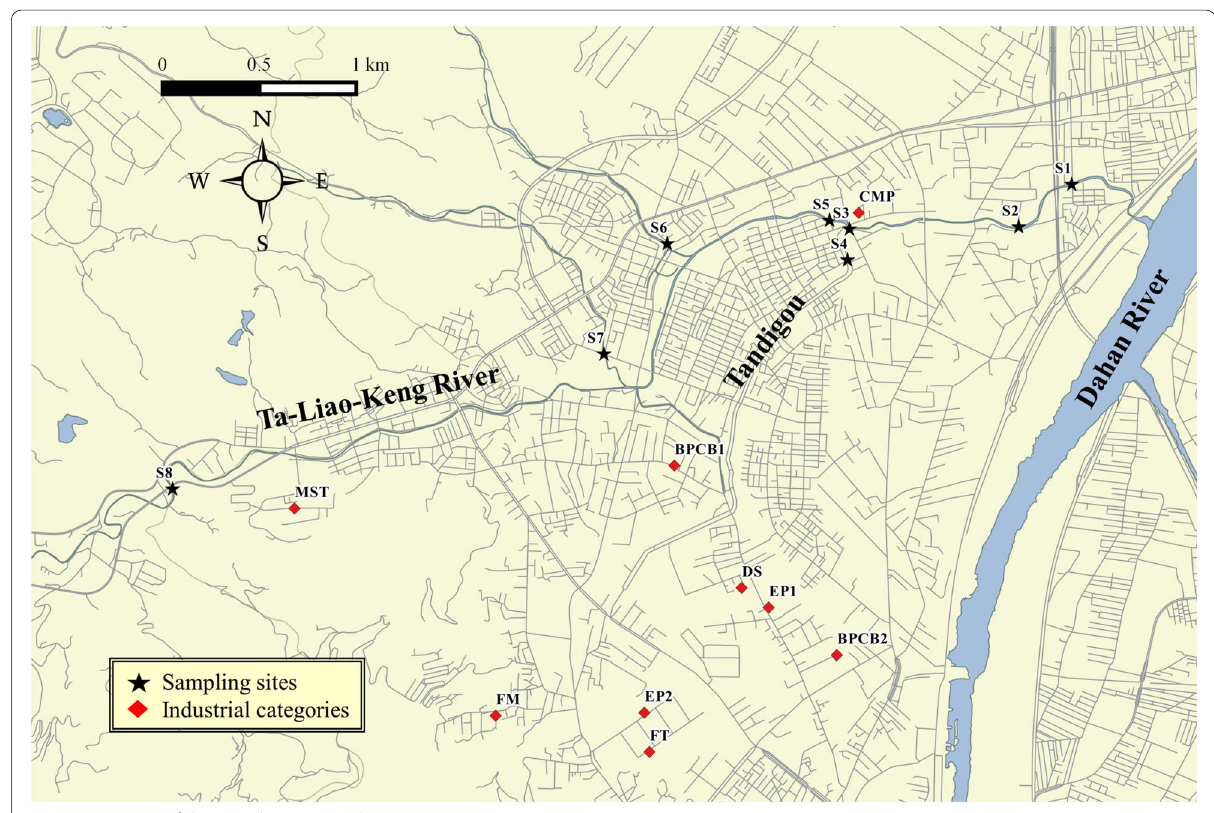
Fig. 1 Locations of the sampling sites in the Ta‑Liao‑Keng River